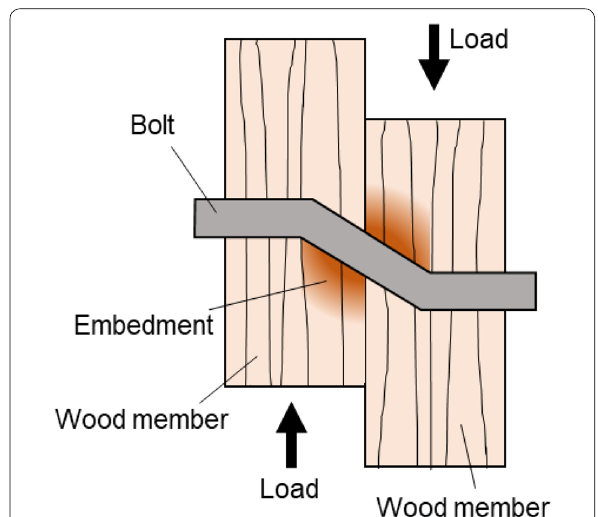
Fig. 1 Deformation image of bolted joint under lateral